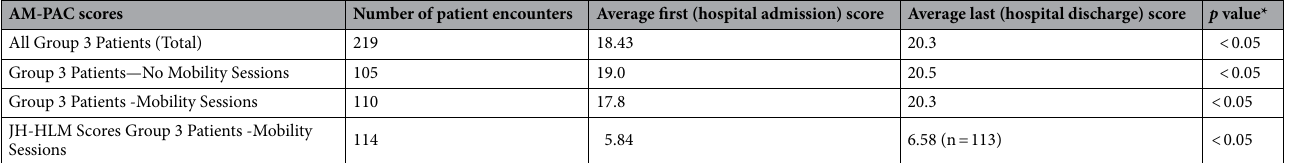
Table 4. Change in function from admission to discharge for Group 3 and two treatment subgroups. * p value represents statistically significant change from first to last score. Between group t-test comparison for Group 3 – No Mobility Sessions and Group 3 – Mobility Sessions. was statistically significant at p < 0.05.